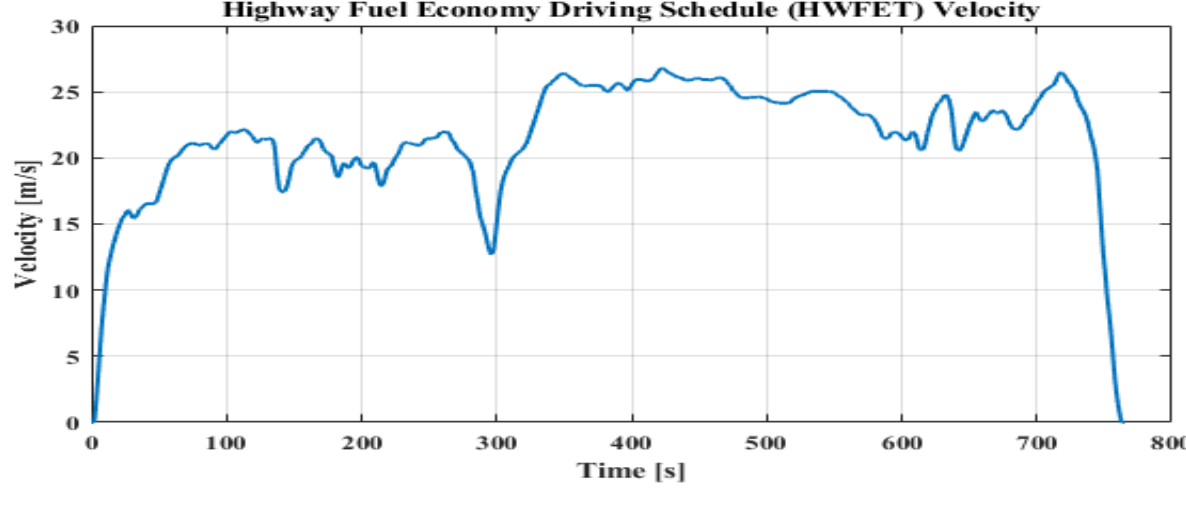
Figure 24. Responses of ultracapacitor current.